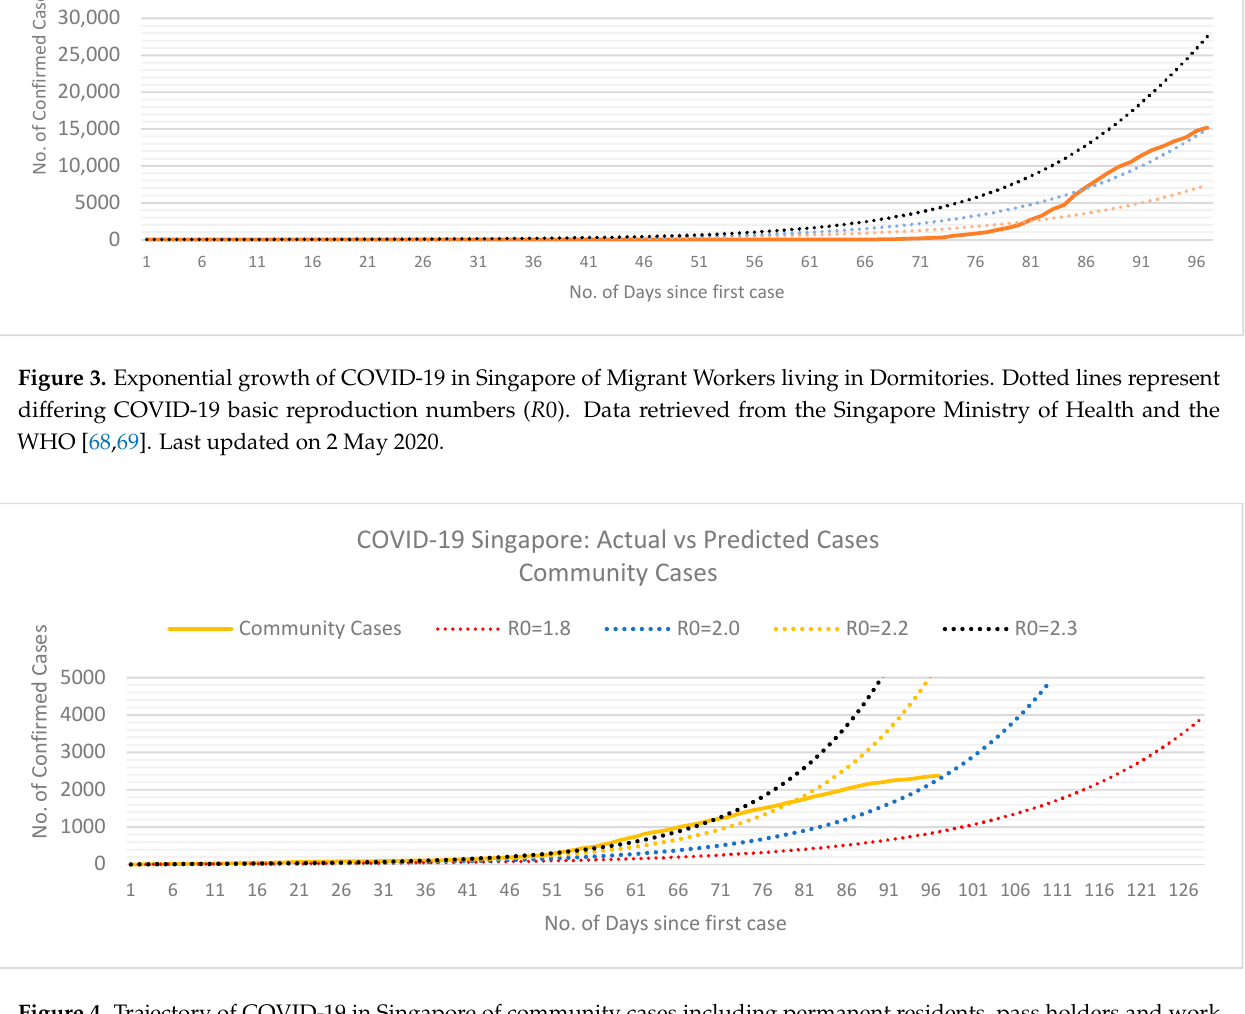
Figure 4. Trajectory of COVID-19 in Singapore of community cases including permanent residents, pass holders and work permit holders (WPH) not residing in dormitories. Dotted lines represent differing COVID-19 basic reproduction numbers ( R 0). Data retrieved from the Singapore Ministry of Health and the WHO [68,69].